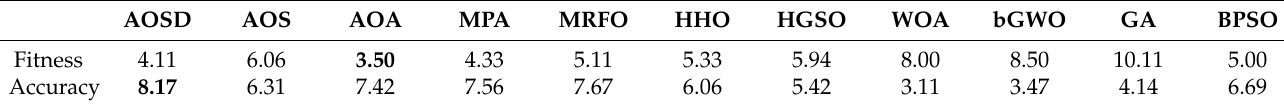
Table 9. Friedman rank test results for all